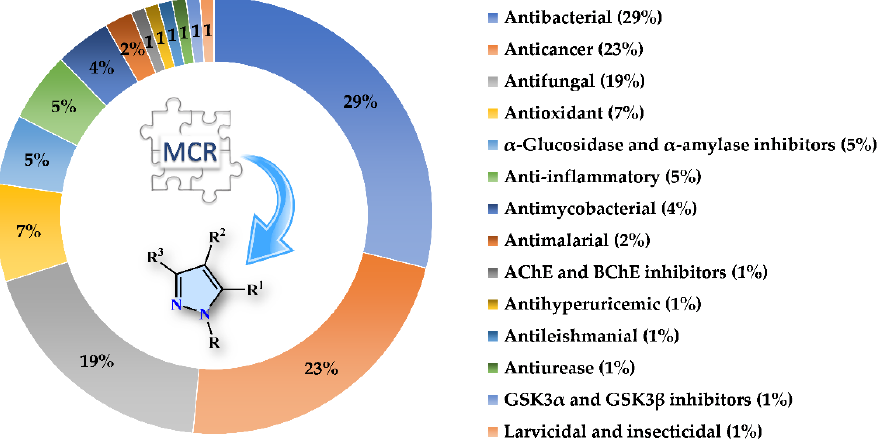
Figure 1. Bibliometric graphic depicting the percentage of articles associated with each biological activity screened from 2015 to date [data were collected searching in Scopus for the keywords: “pyrazole derivatives”, “biological activity”, and “multicomponent reactions”].